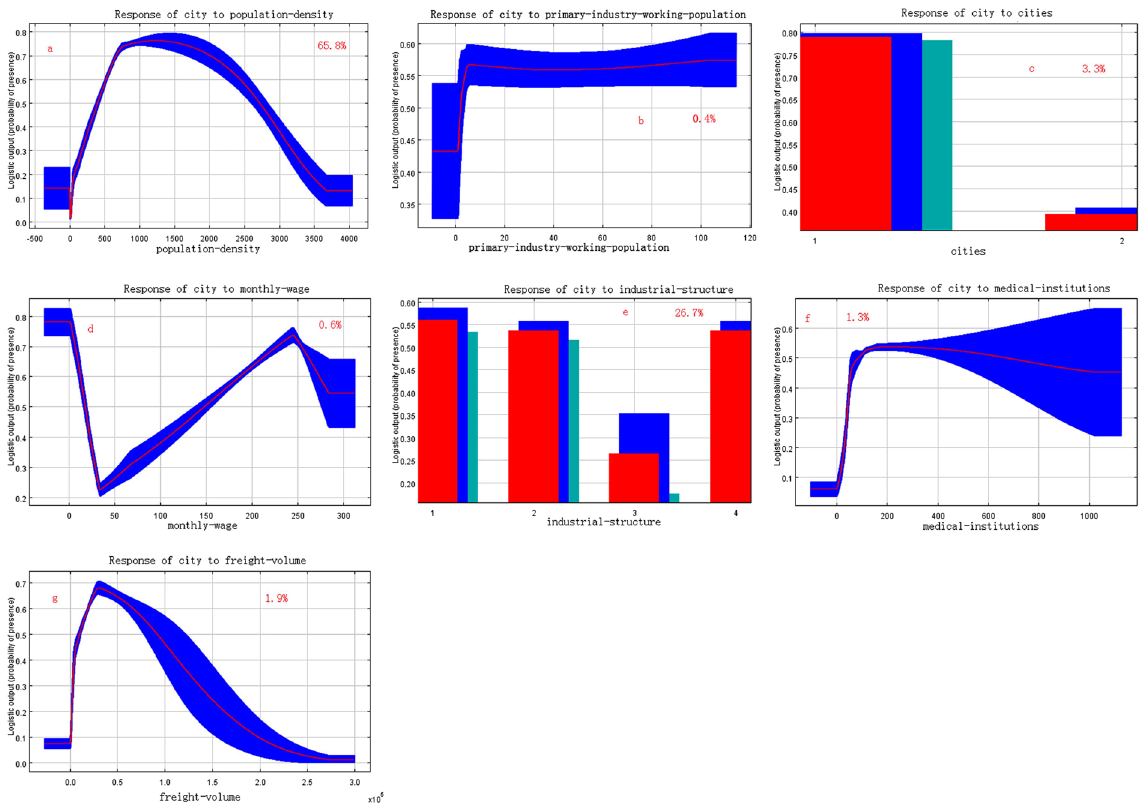
Figure 5. Response curves of Maxent jackknife method and environment variables (( a ) people-density, ( b ) primary-industry-working-population, ( c ) cities, ( d ) monthly-wage, ( e ) industrial-structure, ( f ) medical- institutions, ( g ) freight-volume). The horizontal axis of the response curve indicates the value of the socioeconomic variable, and the vertical axis indicates probability that an area is at risk of being affected by illegal